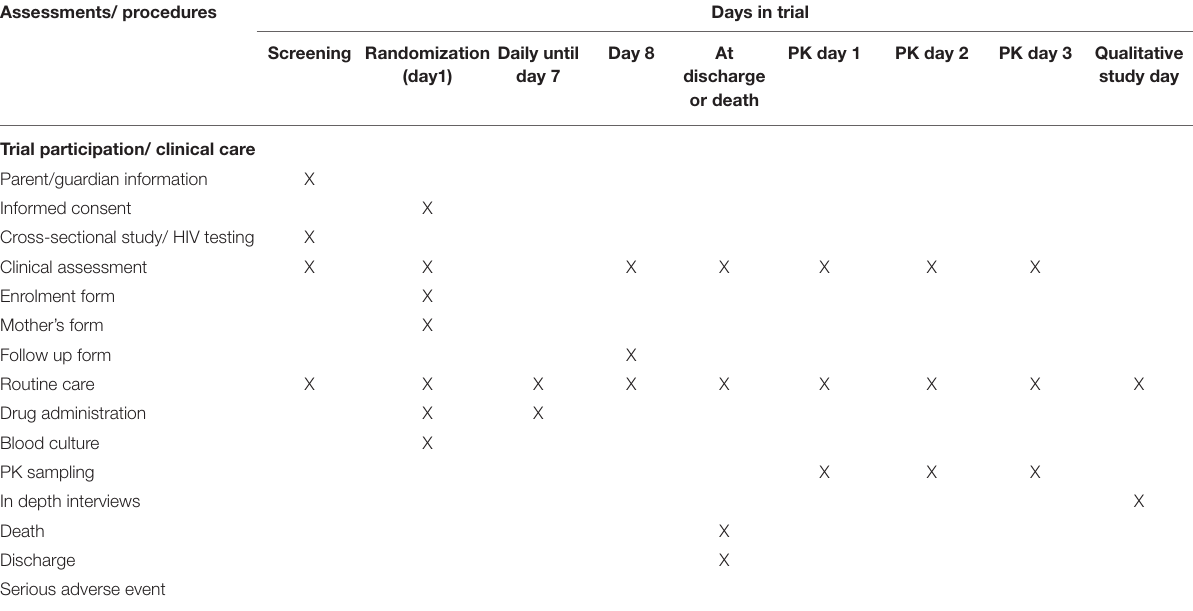
TABLE 1 | Redmothiv trial schema. Assessments/